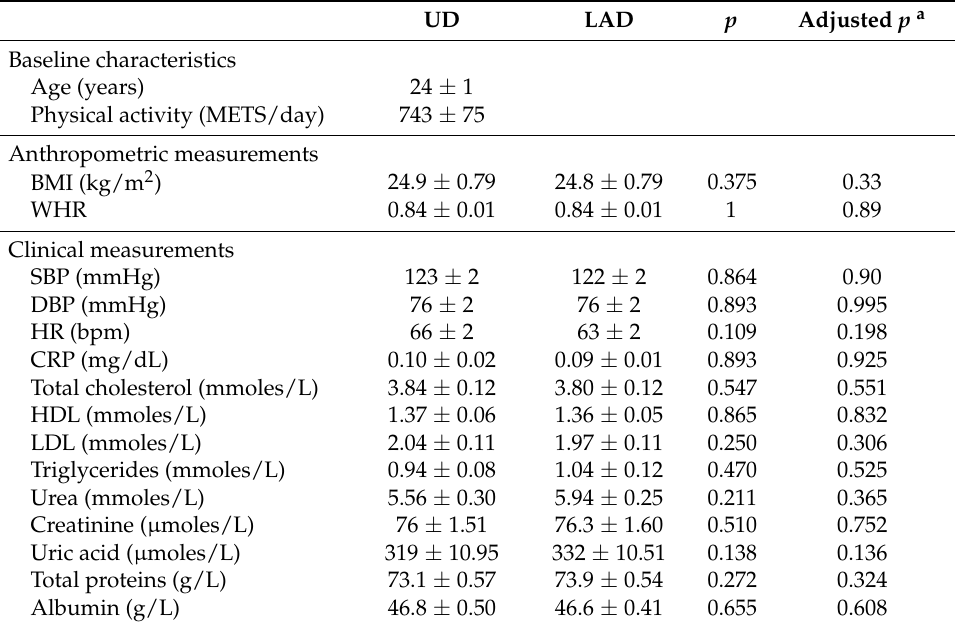
Table 1. Characteristics of all participants of the